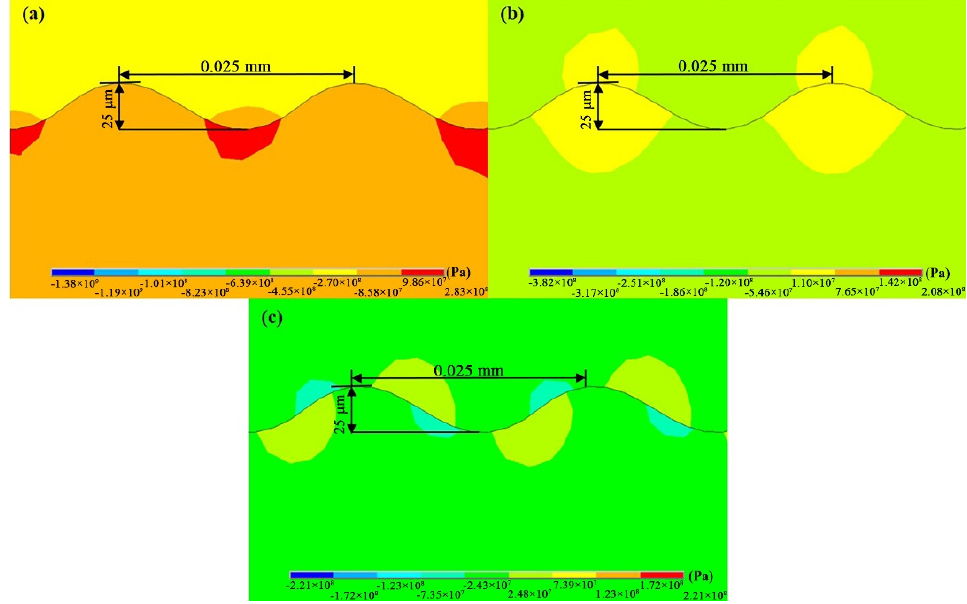
Figure 11. Distribution at the interface with the sine wave morphology: ( a ) radial stress; ( b ) axial stress and ( c ) shear stress.